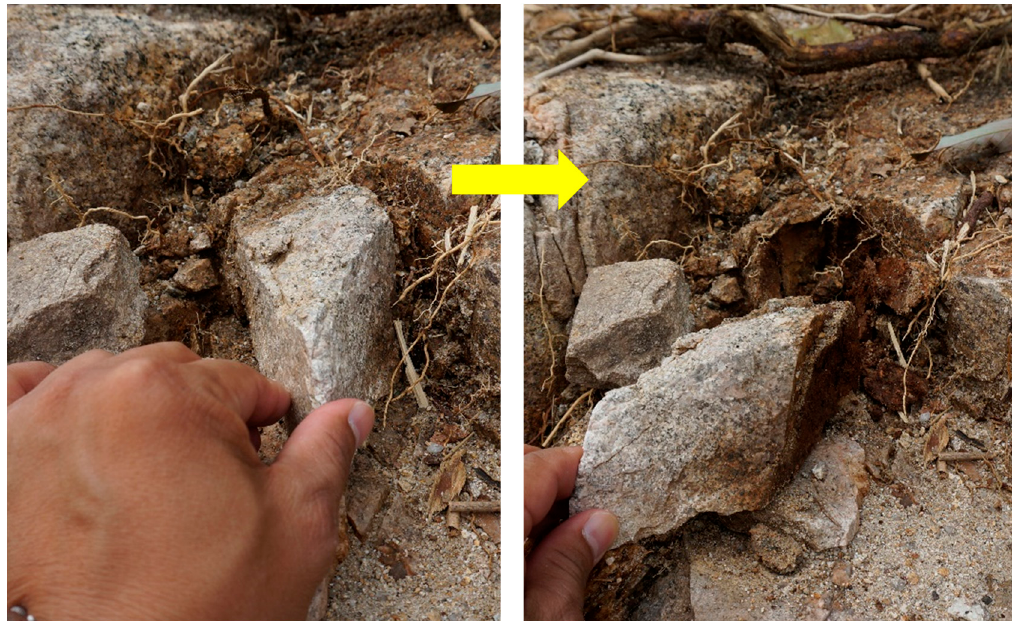
Figure 8. Fragile granite in the valley, Asaminami, Hiroshima.